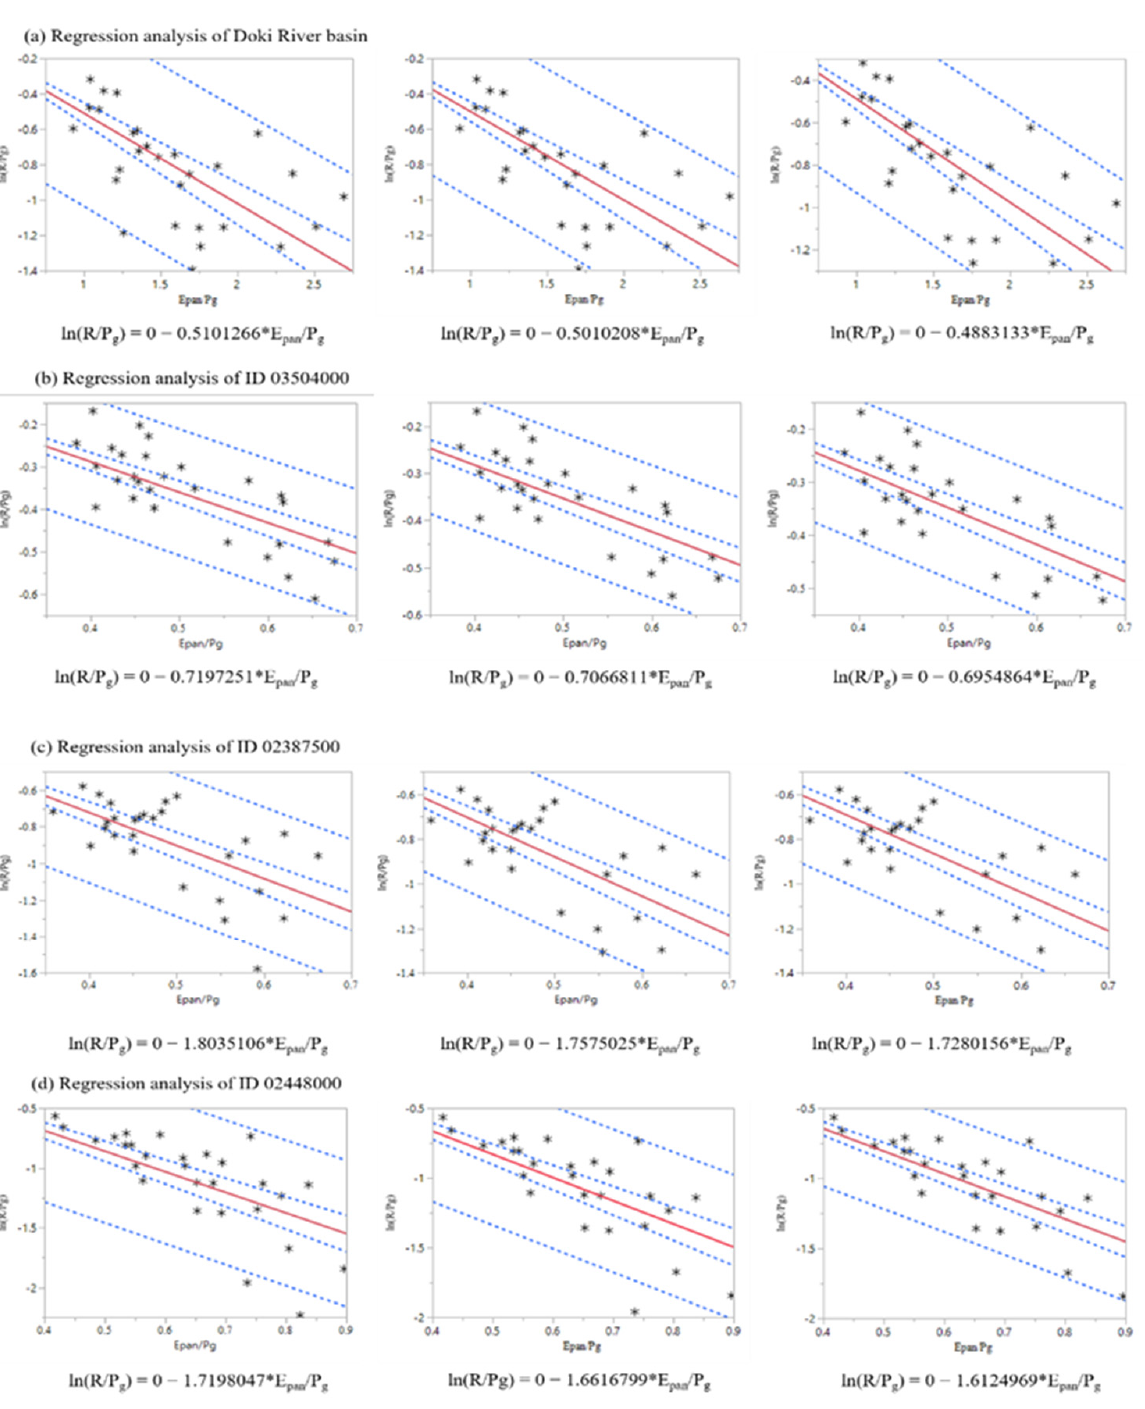
Figure 8. Stages of regression analysis in 28-year datasets for C ep values before and after removing outliers in ( a ) Doki River Basin, ( b ) MOPEX ID 3504000, ( c ) MOPEX ID 2387500, and ( d )